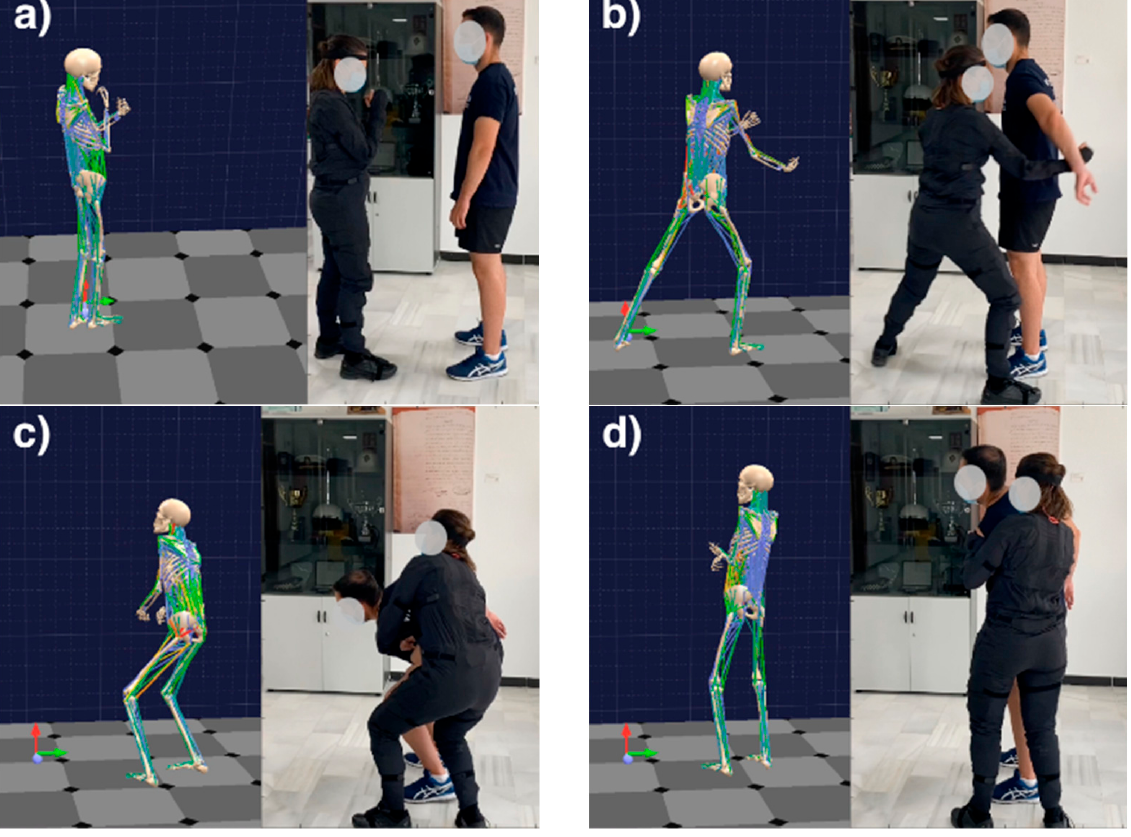
Figure 6. Snapshots of four steps in an OTP implementation: ( a ) at 0.0 s, ( b ) at 1.5 s, ( c ) at 2.6 s, and ( d ) at 3.6 s. Left: Anatomical avatar corresponding to the posture of the police officer on the right hand side image.